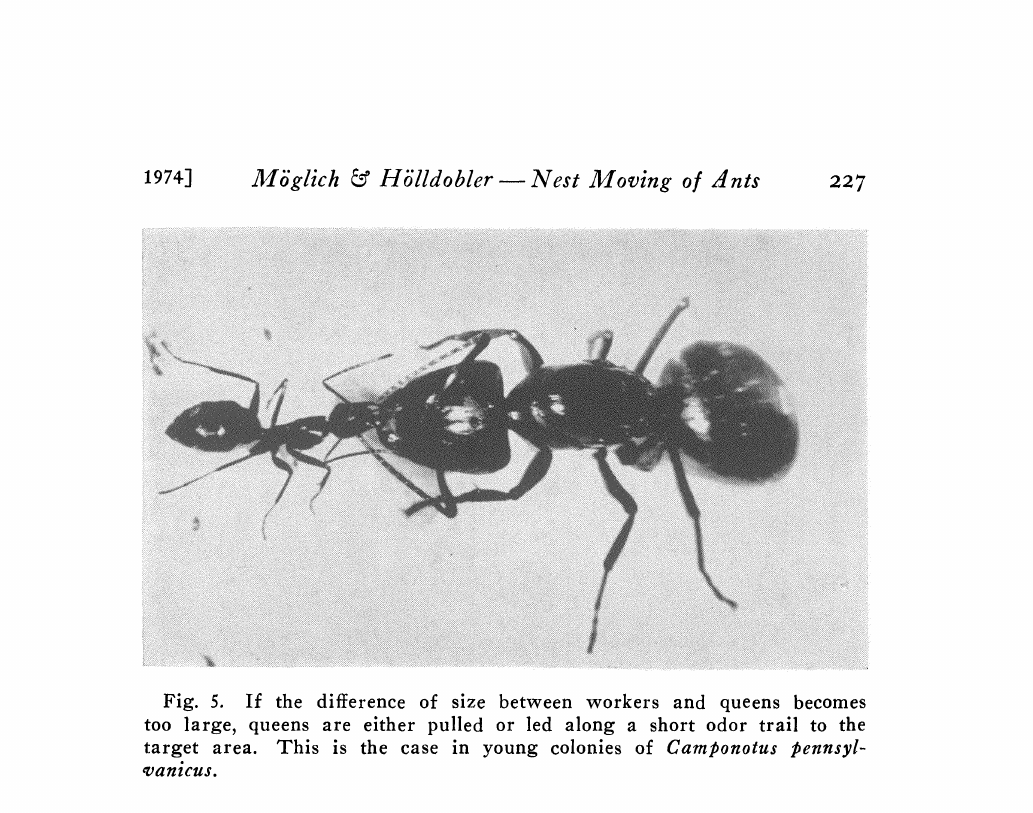
Fig. 5. If the difference of size between workers and queens becomes too large, queens are either pulled or led along a short odor trail to the target area. This is the case in young colonies of Camponotus pennsyl-